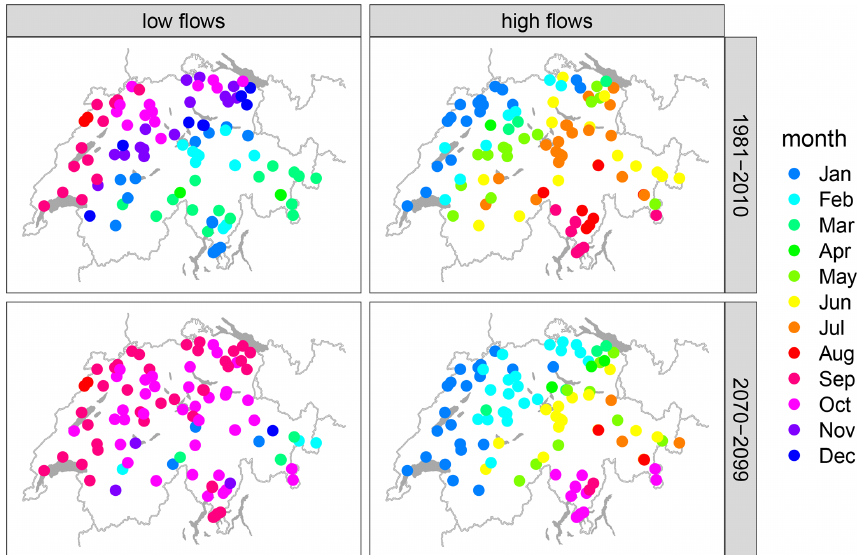
Figure 2. Median monthly occurrence of moderate low flows (left panels) and high flows (right panels) for the reference period (1981–2010, upper panels) and for the end of the century (2070–2099, lower